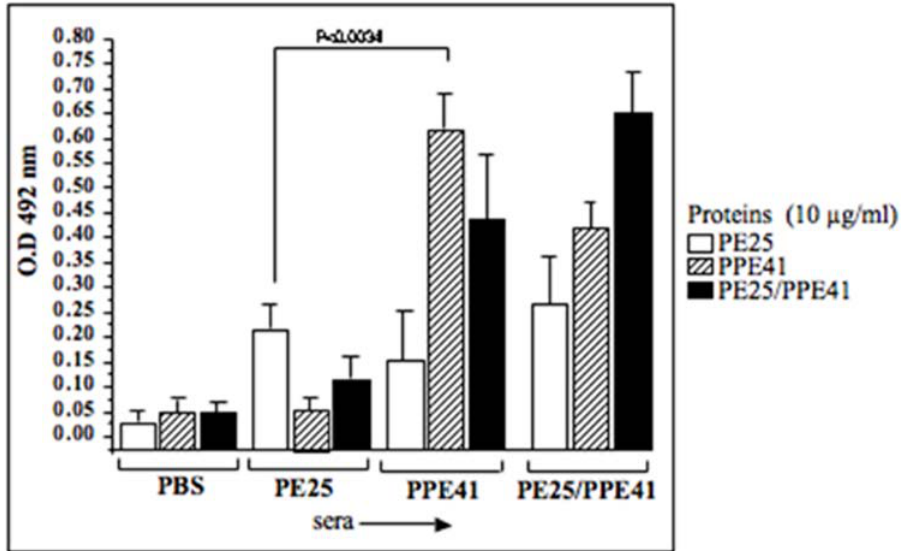
Figure 2. The PE25 protein induces low B cell (IgG) response whereas the PPE41 and PE25/PPE41 protein complex induce high B cell response in mice. ELISA was carried out with sera from mice immunized with the PE25, PPE41 and PE25/PPE41 recombinant proteins without any adjuvant, and screened for antibody against the respective recombinant proteins. The X-axis represents the sera from mice immunized with PBS, PE25, PPE41 and PE25/PPE41 proteins and the different bars (as indicated) represent the B cell response against each of the proteins. The p value is calculated between the groups of mice immunized with the PE25 and PPE41 proteins. The data shown represent three independent experiments carried out in triplicates.